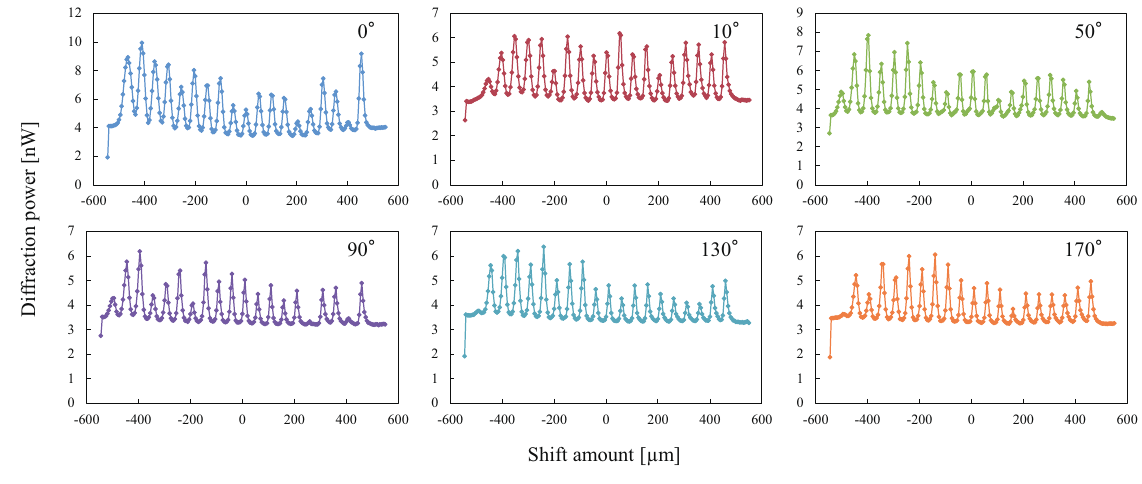
Figure 9. Evaluation results of shift-peristrophic